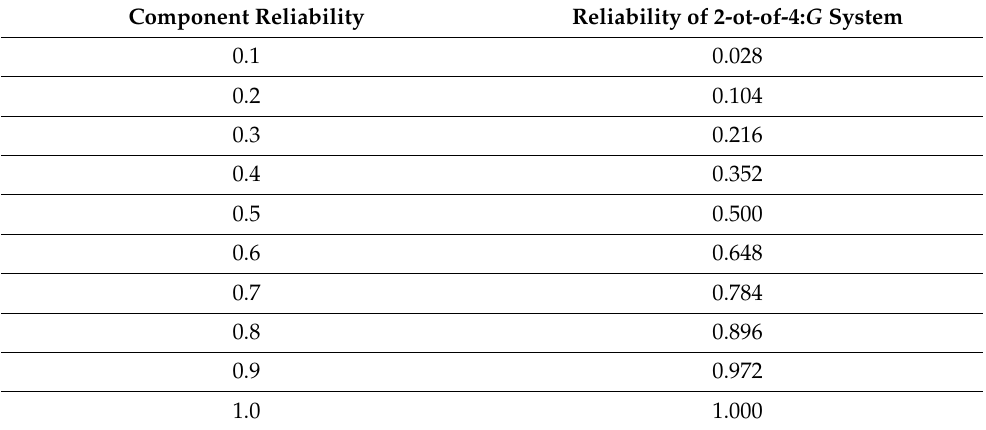
Table 4. The values of reliability of 2-out-of-4: G system.